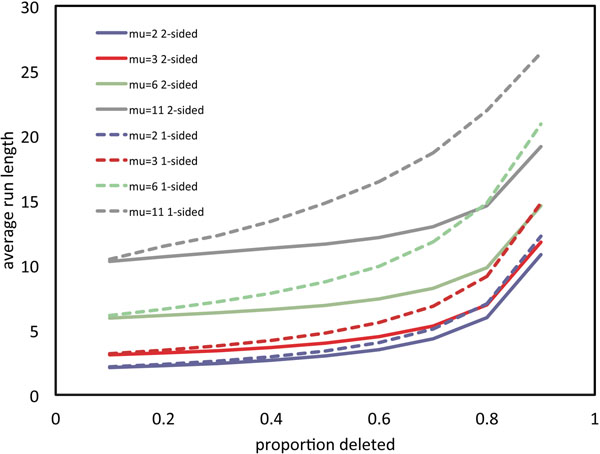
Comparison of models Average length of run of single copy genes in one-sided and two-sided models for µ = 2, 3, 6,11.